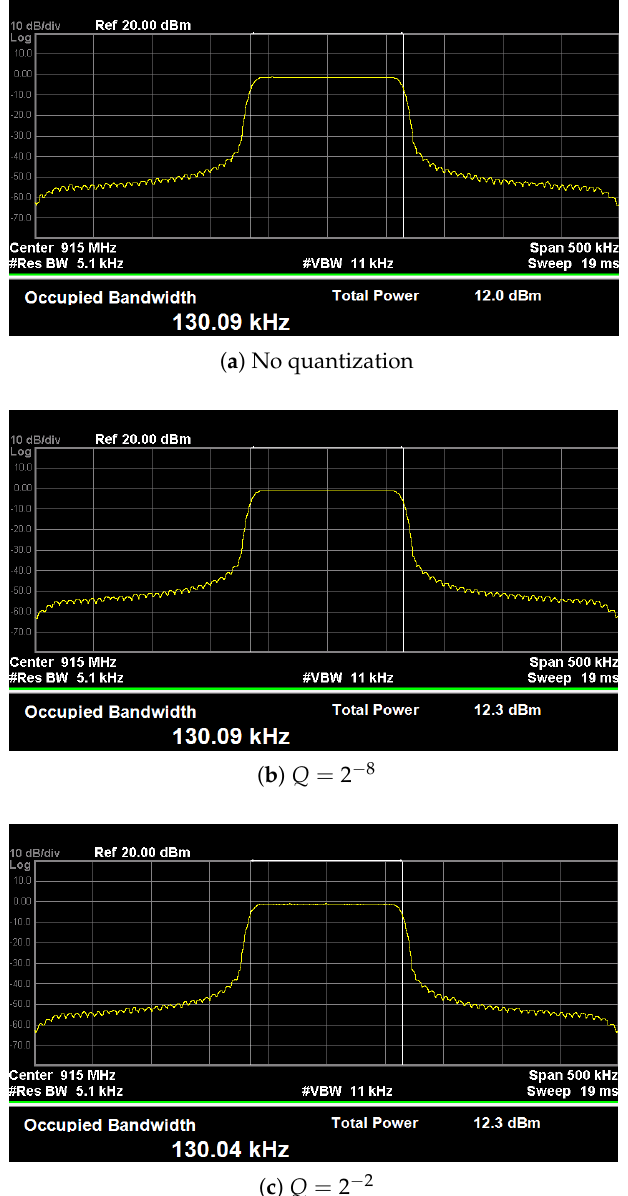
Figure 3. Occupied bandwidth measurements of filtered transmit signals with and without quantization when SF = 10 and BW = 125